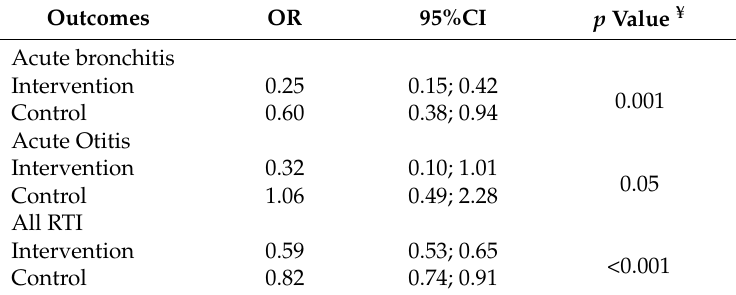
Table 3. Reduction in prescription of antibiotics in patients with suspected RTI within and across randomization